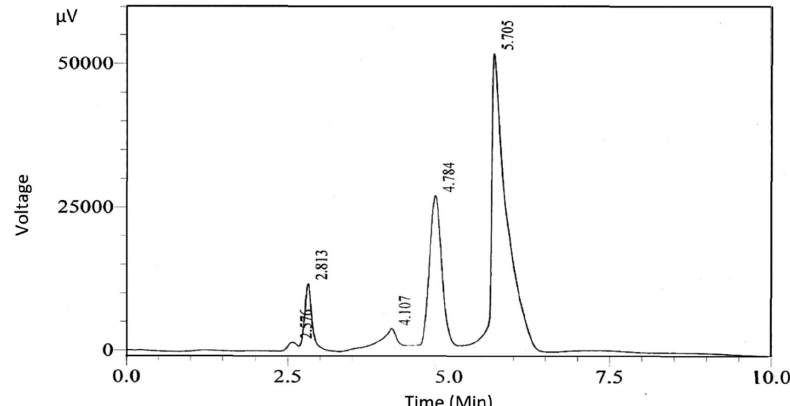
Fig. 1 . HPLC chromatogram of the M. oleifera protease inhibitor. Two main peaks with retention times of 4.784 and 5.705 min were detected.